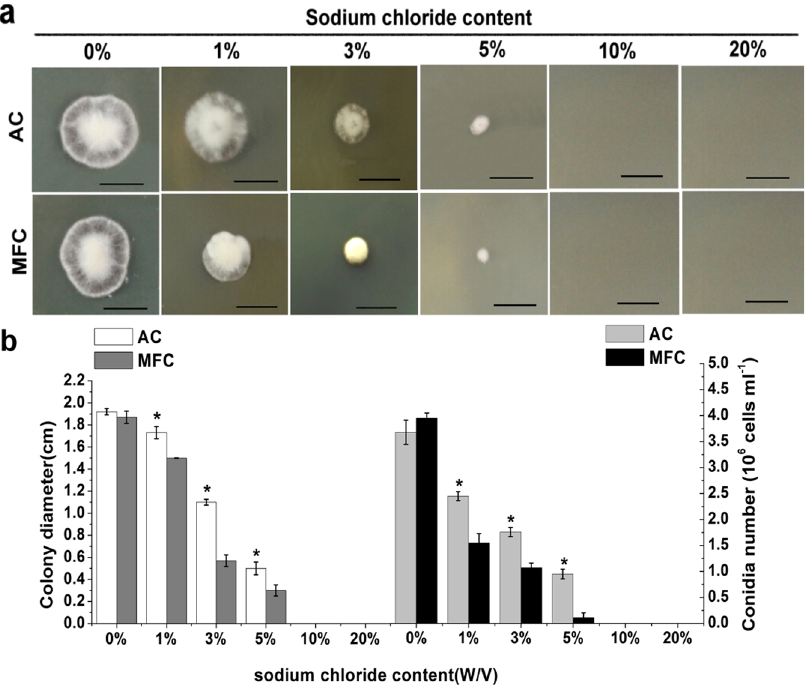
Figure 3. Sodium chloride tolerance test of two spores from Hirsutella satumaensis . ( a ) Colonial morphology of two spores at increasing NaCl content. MFC is more susceptible to NaCl and experience drastically depressed growth, with no colonies evident at a NaCl concentration of 10% (w/v). Bar = 1 cm. ( b ) Statistics of two spores colony diameter and conidiation on NaCl medium rangeing from 0% to 10%. The MFC display an approximately 80% reduction in conidiation relative to AC, particularly at 5%. Statistical analysis was performed using a one-way ANOVA. Error bars are standard deviations of three trials and panels are representative of at least 2 independent experiments, * p < 0.05.